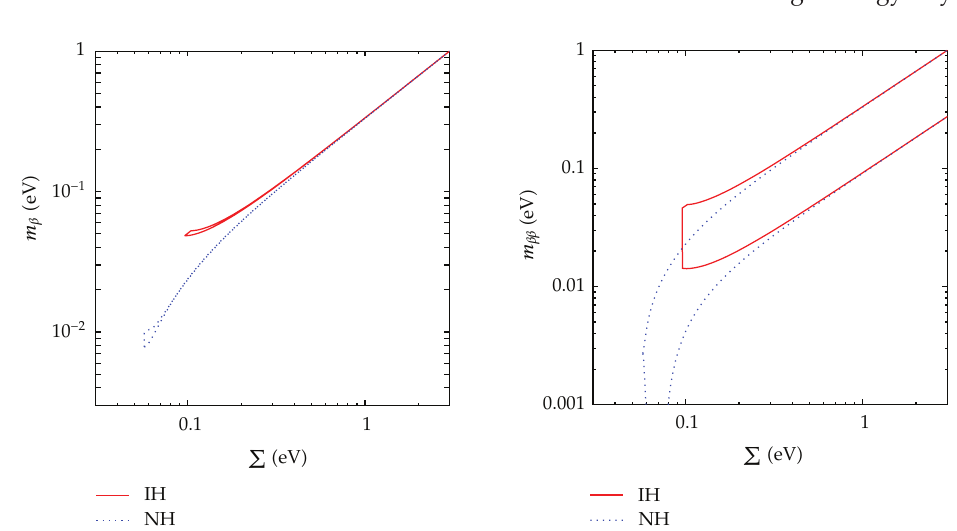
Figure 6: Allowed regions by oscillation data at the 3 σ level (cid:2) 5.3 (cid:3) of the three main observables sensitive to the absolute scale of neutrino masses. We show the regions in the planes m β - Σ and m ββ - Σ , see the text for the corresponding definitions. Blue dotted (cid:2) red solid (cid:3) regions correspond to normal (cid:2) inverted (cid:3)